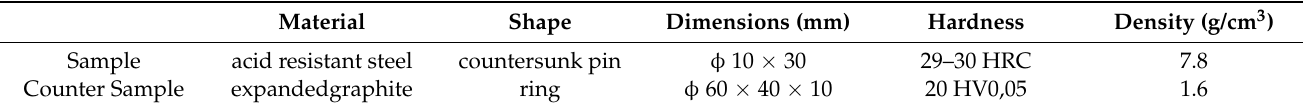
Table 1. Material data sample and counter